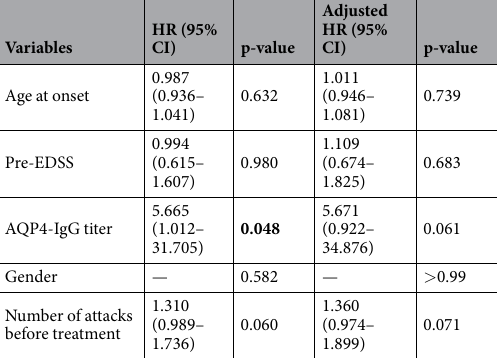
Table 4. Cox proportional hazards analysis of relapse. HR: hazard ratio; CI: confidence interval; Pre-EDSS: Expanded Disability Severity Scale before tacrolimus treatment. In the univariate Cox proportional hazards regression model, the titer of AQP-4 antibodies before tacrolimus treatment was associated with relapse after treatment (HR: 5.665 95% CI: 1.012–31.705, P = 0.048). However, multivariate analysis revealed that the difference did not reach statistical significance (P = 0.061). The number of attacks prior to tacrolimus treatment, gender, EDSS before treatment, and age at onset were not associated with relapse when tacrolimus treatment was commenced in either univariate or multivariate